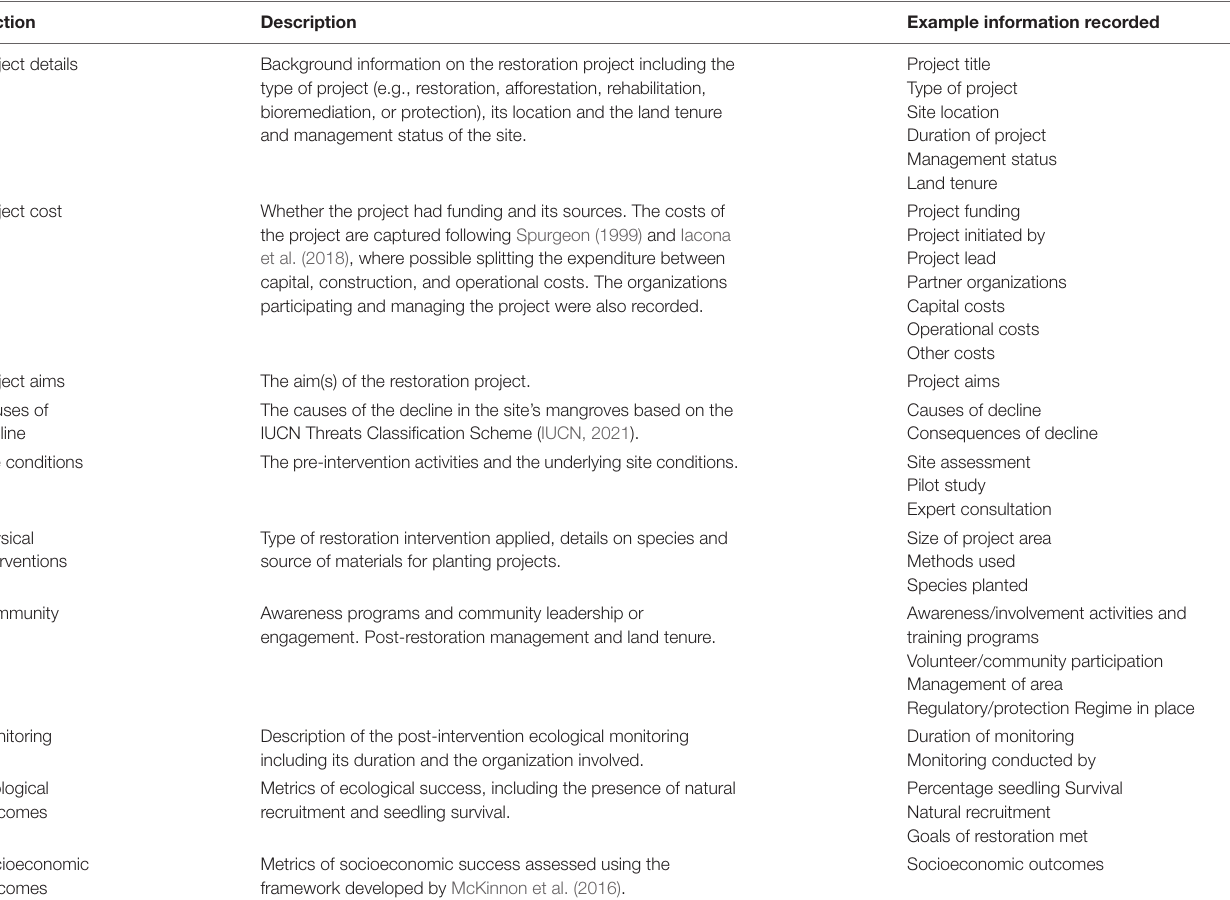
TABLE 1 | Overview of the mangrove restoration assessment